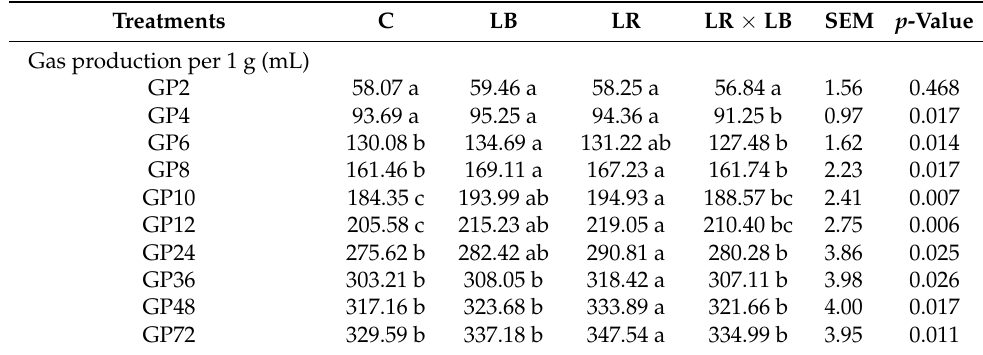
Table 3. In vitro gas production of paper mulberry